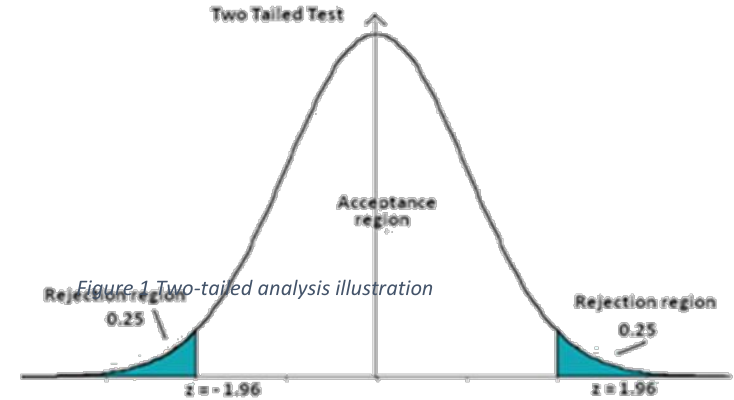
Figure 2 Two-tailed Analysis